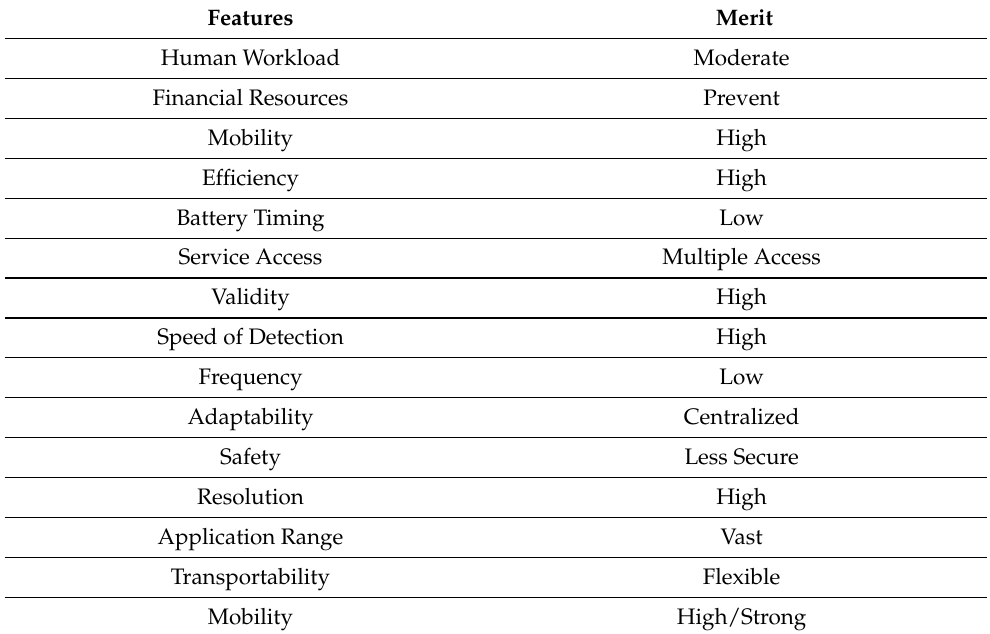
Table 1. UAV features in target